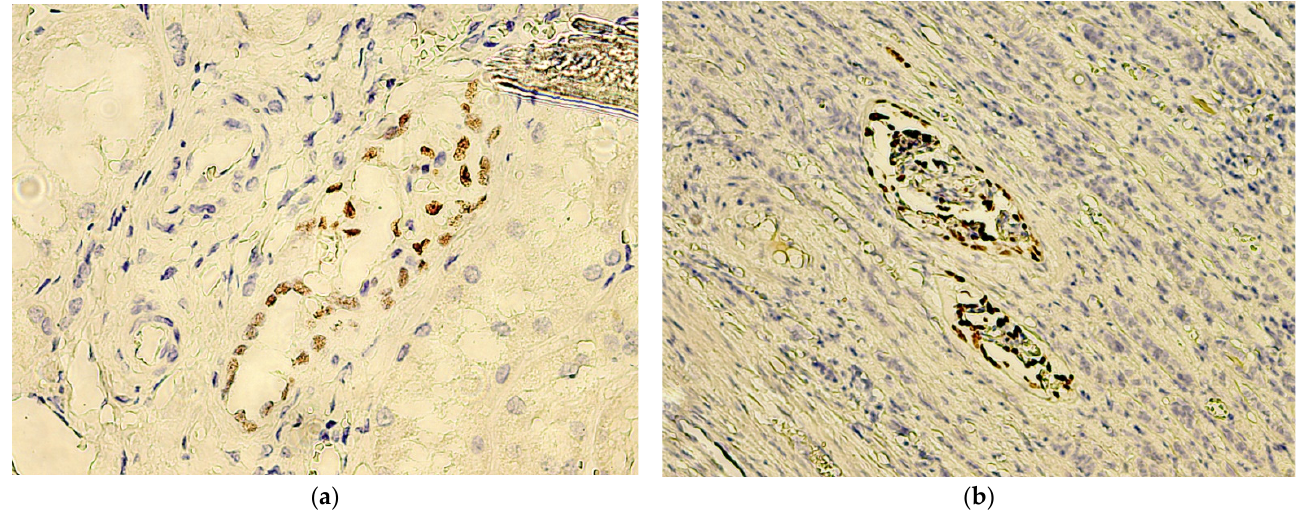
Figure 3. WT1 IHC staining : ( a ) 400×, positive connecting tubule cells, low-to-moderate nuclear staining; ( b ) 200×, positive renal corpuscles with severe degenerative lesions, compressed by neigh- boring tumor tissue, but with relatively unaffected podocytes.